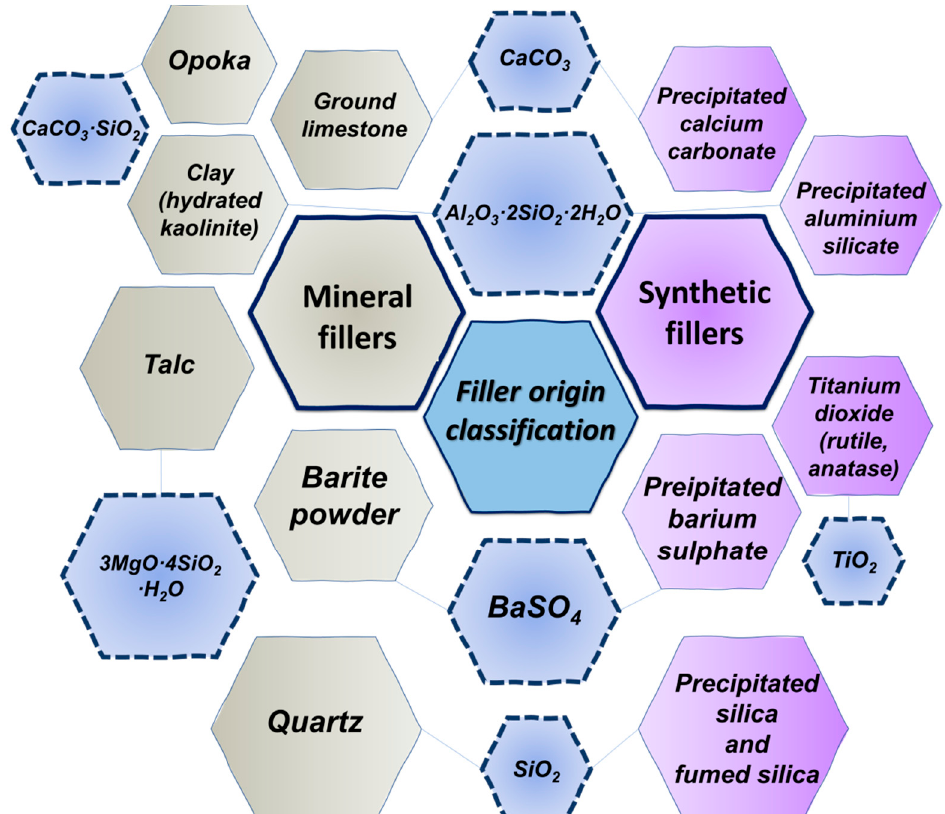
Figure 1. The division of fillers according to the origin of the material (thick frame) with examples (thin frame) and chemical formulas (dotted line).